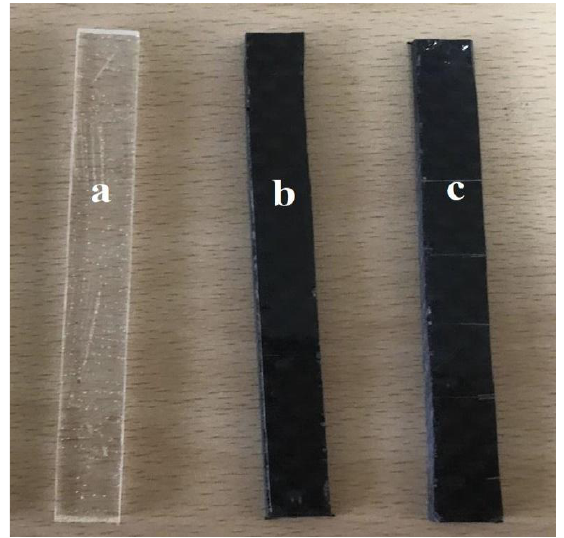
Figure 1. Laminate samples for testing ( a ) E ( b ) E-C1 ( c ) E-C1S2B2.